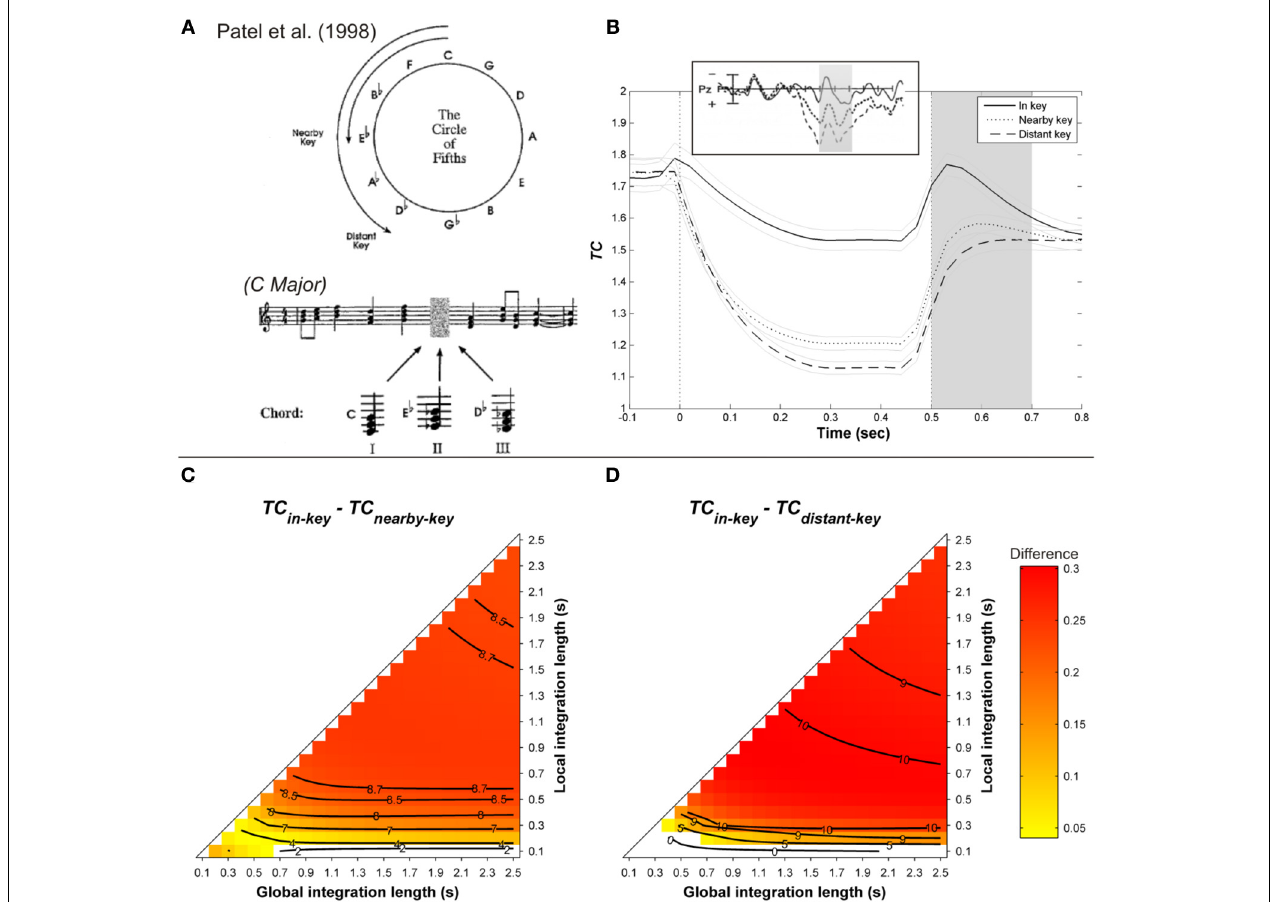
FIGURE 6 | (A) Example of harmonic sequences used by Patel et al. (1998). (B) Mean running TC ( t ) of the target chord, as a function of its distance with the harmonic context (in-key, nearby, and distant-key: solid, dashed, and dotted line, respectively), computed with a local and global context integration windows of 0.3 and 1.5s, respectively. Light gray lines represent standard errors. Insert: corresponding ERP responses. Gray area is the time